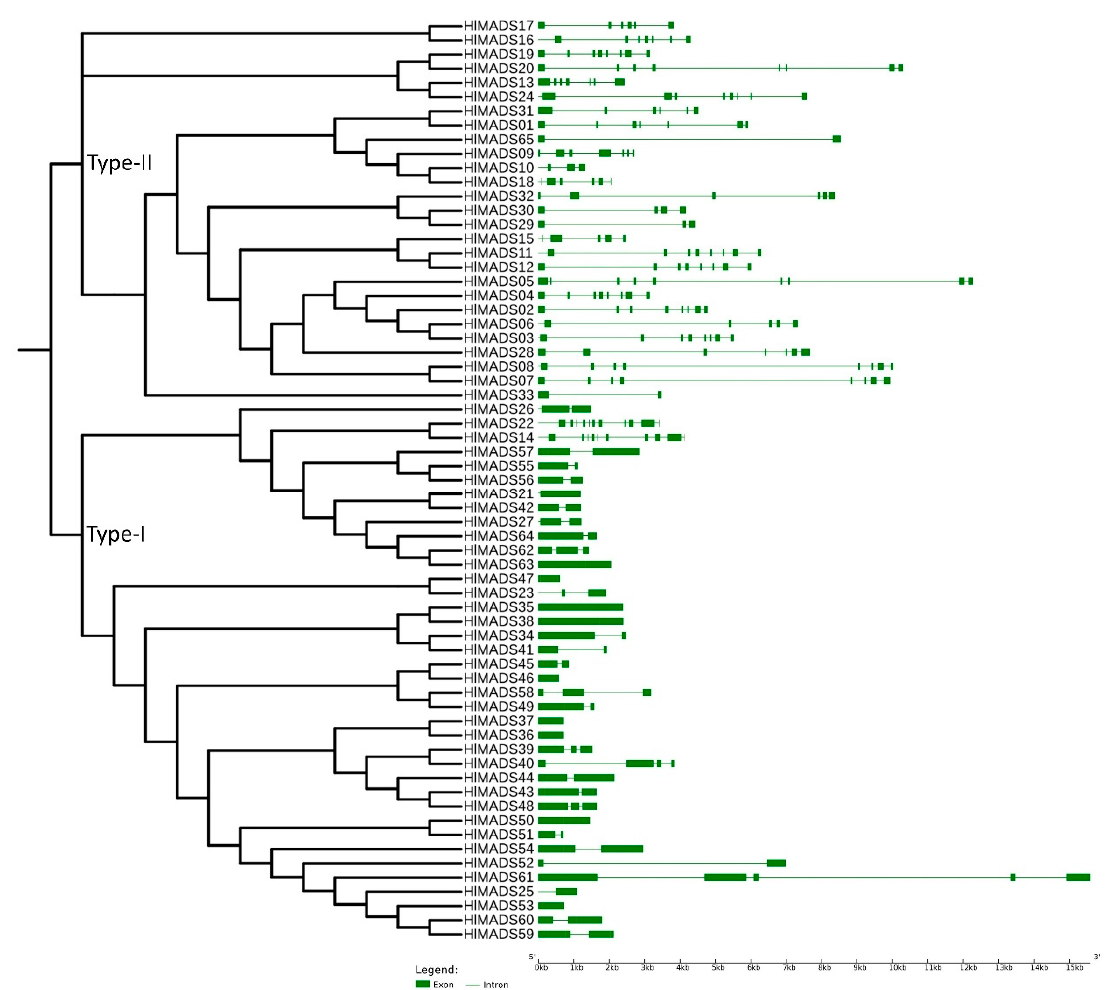
Figure 3. Phylogenetic tree and structure of 65 hop MADS-box genes. Exons are represented by green solid boxes, and introns by green lines.